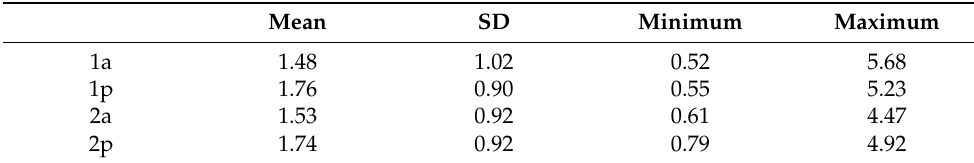
Table 1. Mean, SD, minimum and maximum values of BTU intensity for each of the 4 tibial zones analysed.